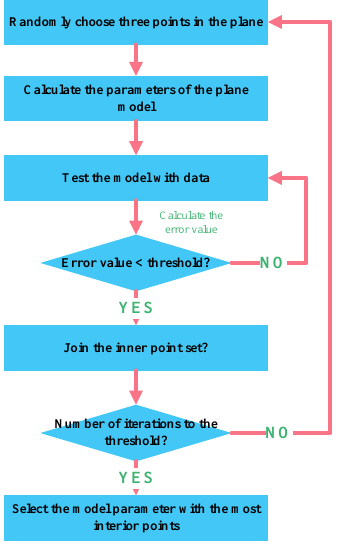
Figure 1. The flow of the random sampling consensus